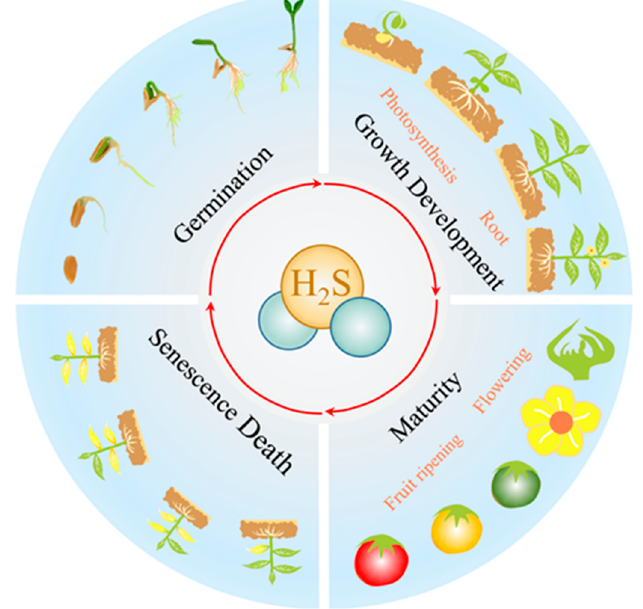
Figure 4. H 2 S is involved in the growth and development of plants.